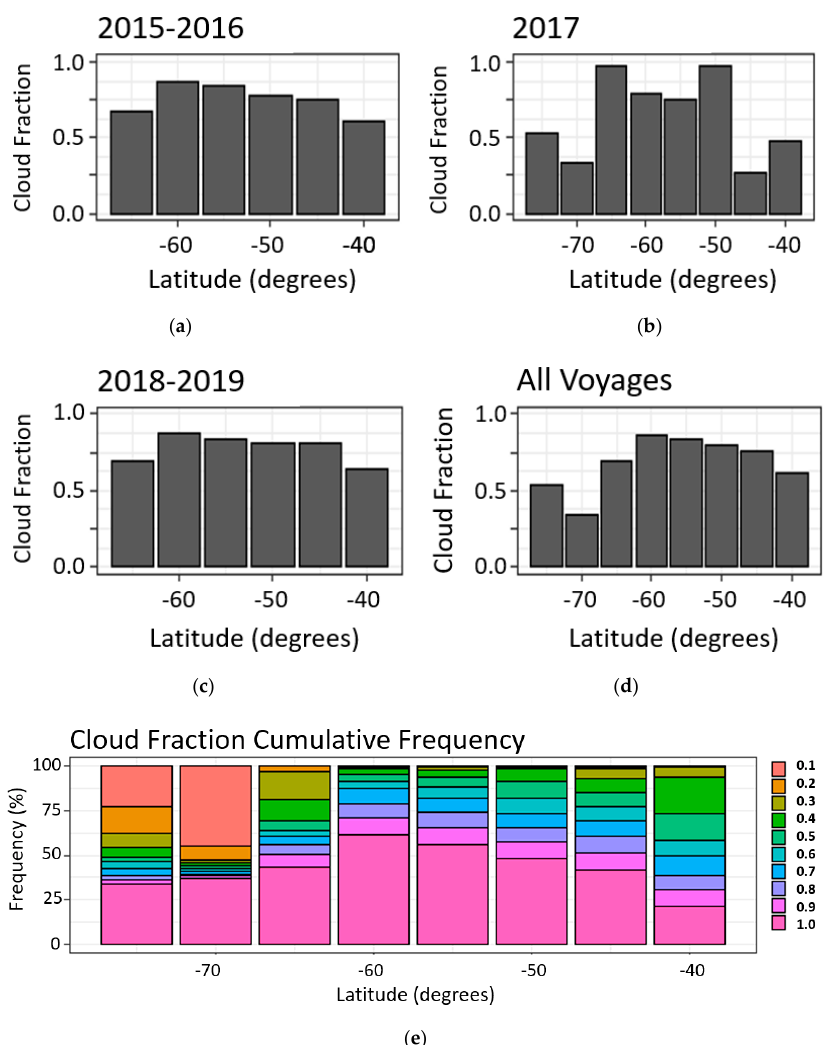
Figure 6. The average cloud fraction (%) in 5-degree latitude bands for ( a ) the 2015 to 2016 voyages, ( b ) the 2017 voyage, ( c ) the 2018 to 2019 voyages, ( d ) over all voyages and ( e ) over all voyages but shown as a cumulative frequency distribution.